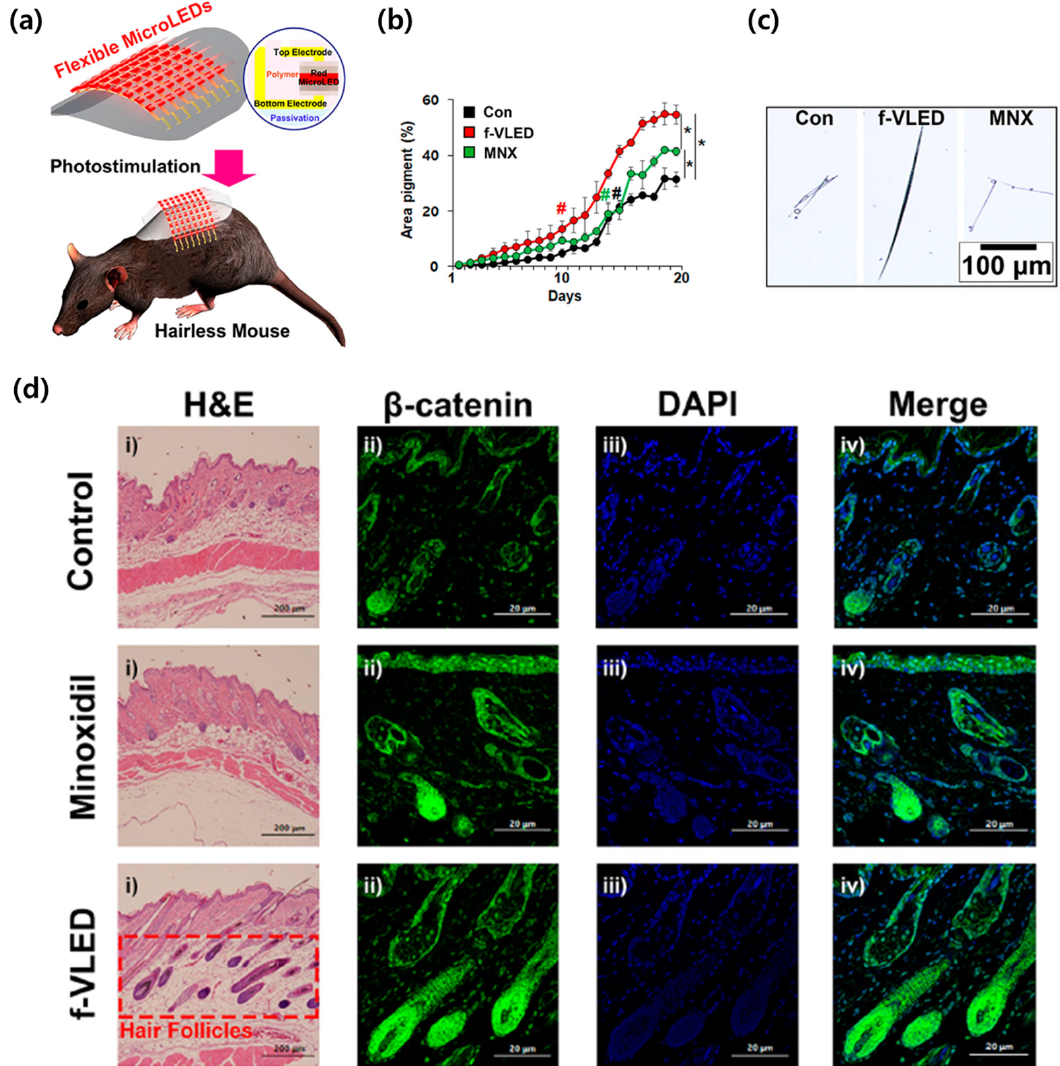
Figure 9. ( a ) Schematic illustration of trichogenic photostimulation by flexible red μ LED patch. ( b ) Areal trend of hair regrowth for 20 consecutive days. ( p < 0.05, paired t test, # p < 0.05, two way ANOVA; * p < 0.01, *** p < 0.001, paired t test)( c ) Magnified microscopic images of mouse dorsal hair after trichogenic stimulation tests. ( d ) Histological and fluorescence images of mouse skin after 20 days of trichogenic stimulation tests. Reproduced with permission [33]. Copyright 2018, American Chemical Society.